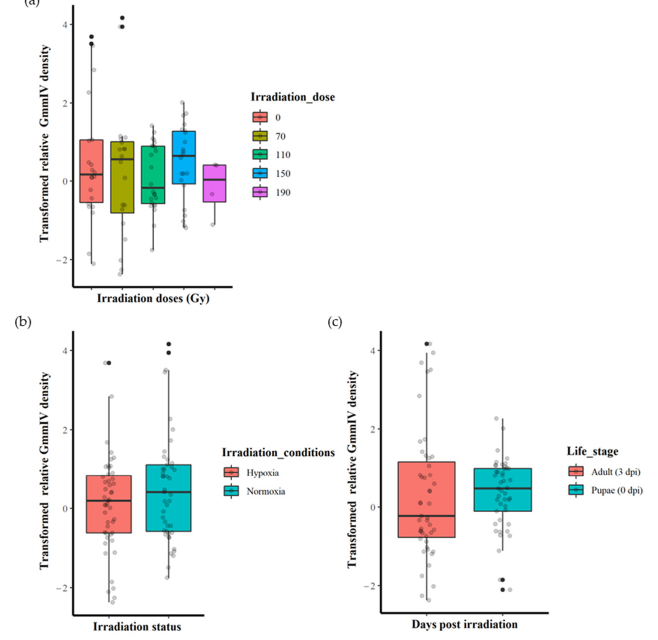
Figure 1. Effect of irradiation doses, irradiation conditions and host life stage on the GmmIV densities in G. morsitans morsitans . ( a ) GmmIV densities as affected by irradiation dose, regardless of irradiation conditions (normoxia or hypoxia) and host life stages. ( b ) GmmIV densities as influenced by irradia- tion conditions (irradiation in normoxia or hypoxia), regardless of irradiation dose and life stages. ( c ) GmmIV densities as affected by life stages, regardless of irradiation dose and irradiation conditions (irradiation normoxia or hypoxia). There were no significant differences observed ( p > 0.05). The dots refer to individual measurements, black dots indicate a second measurement with equal value.